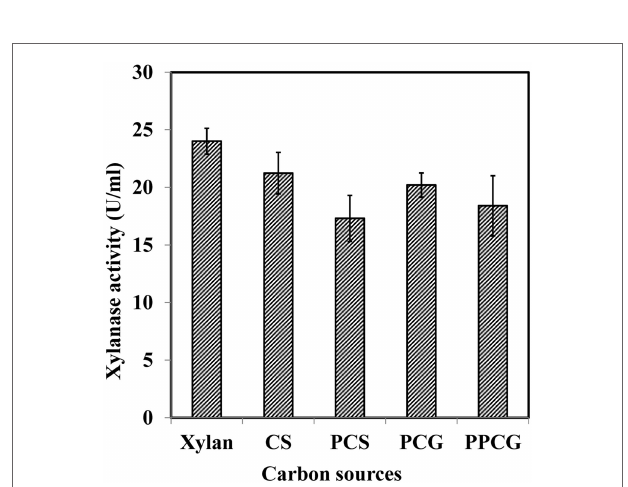
FigUre 2 | effects of xylan and various inexpensive lignocellulosics (prairie cordgrass – Pcg, corn stover – cs, pretreated prairie cordgrass – PPcg, and pretreated corn stover – Pcs) on xylanase production by WsUcF1 .